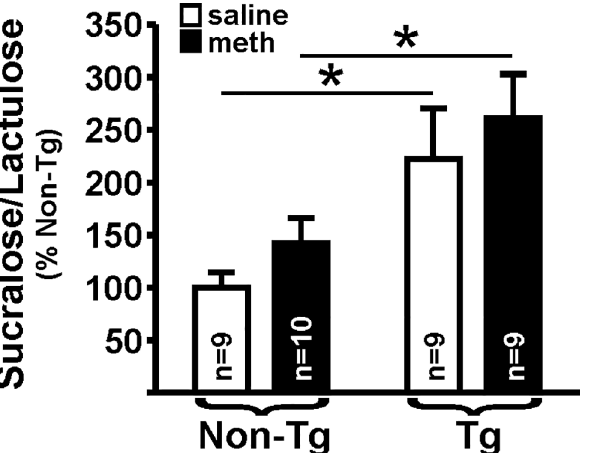
Fig 2. Colon permeability. Tg rats, regardless of methamphetamine self-administration, exhibited a significantly more permeable colon, as assessed the by the sucralose/lactulose ratio, compared to non-Tg saline yoked-rats ( p = 0.001). Methamphetamine self-administration did not result in a significant difference ( p = 0.25), and there was no interaction between genotype and meth ( p = 0.96). Horizontal lines indicate planned contrasts that showed differences with a Newman-Keuls post hoc test ( (cid:3) p <